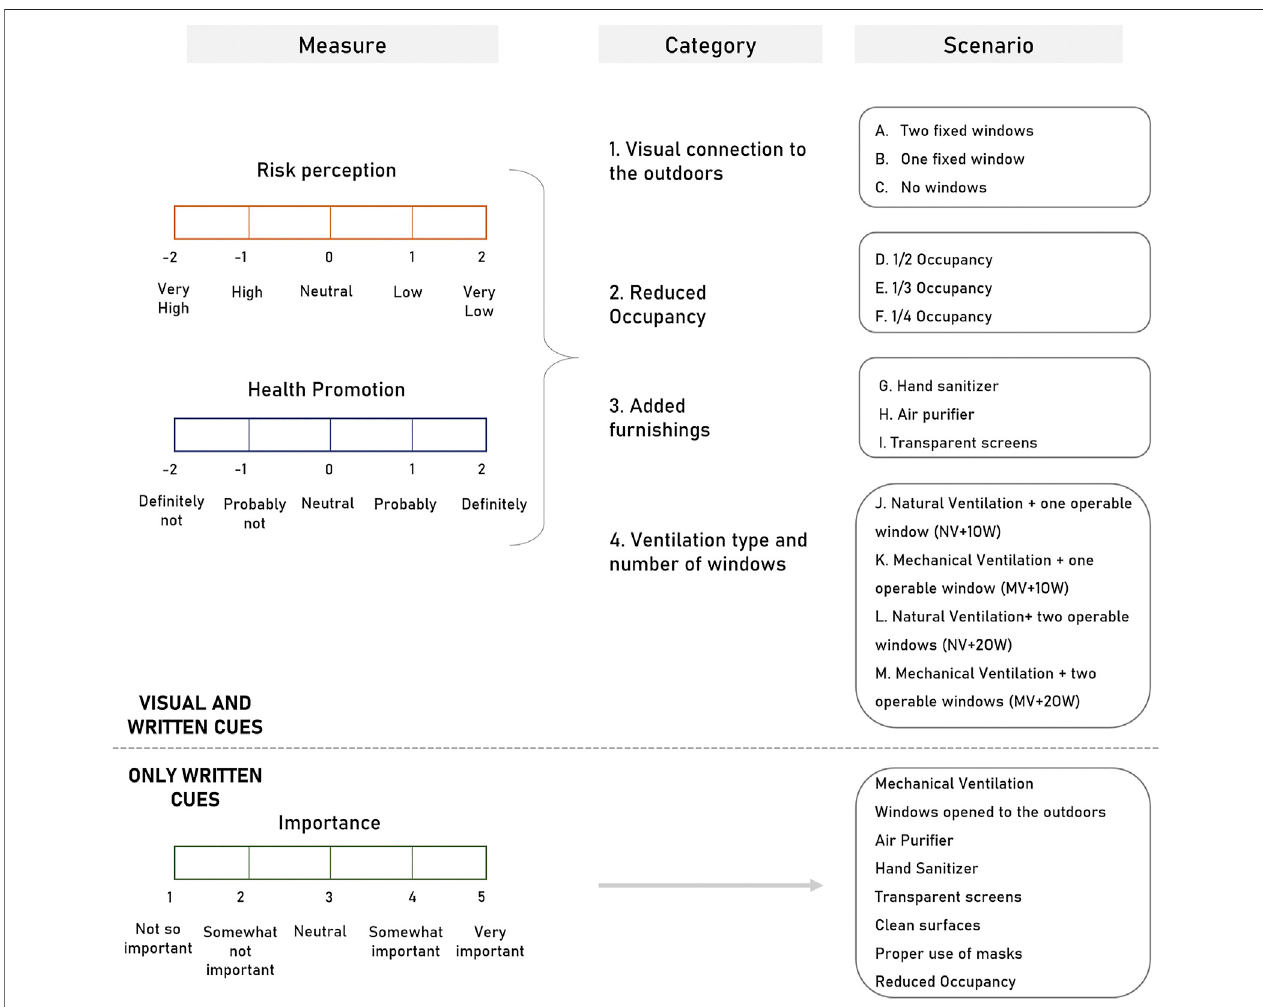
FIGURE 2 | Structure of the